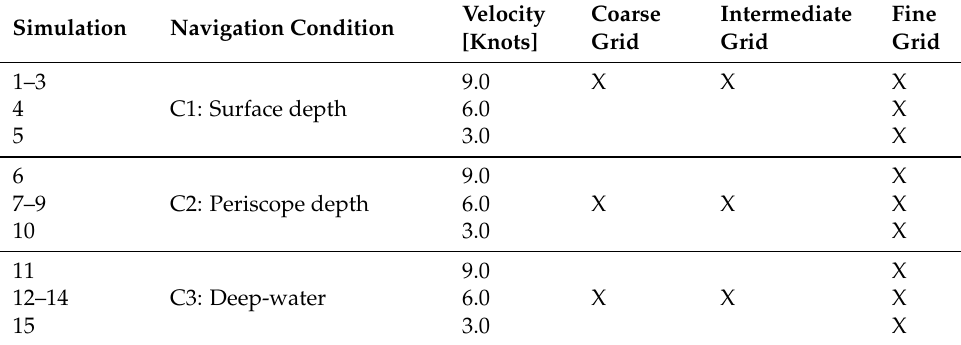
Table 6. Parameters used in each of the simulations in the present study of the Type 209/1300